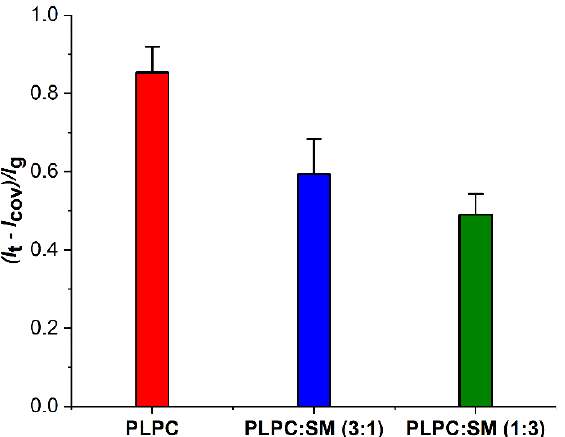
Figure 2. Normalized recovery peak currents of ferrocyanide/ferricyanide redox system determined by differential pulse voltammetry of lipid bilayers on gold electrodes before ( I cov ) and after 30 min plasma treatment ( I t ) ( n = 3). Varied is the SM fraction in PLPC bilayers. Each system is normalized with respect to the peak current of the redox system for the bare gold electrode I g .